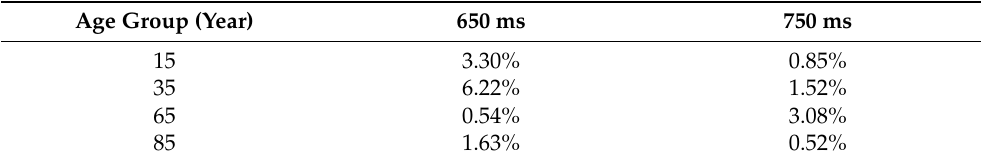
Table 3. Relative AI errors of reconstructed pulse wave.